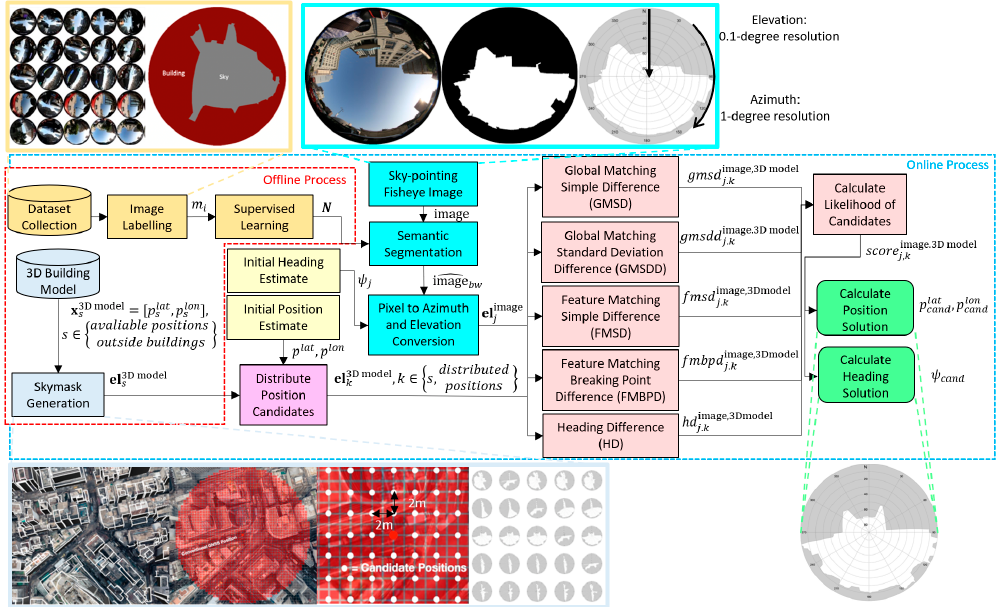
Figure 1. Flowchart of the proposed skymask matching based on images taken by sky ‐ pointing fisheye camera and skymask generated by 3D building